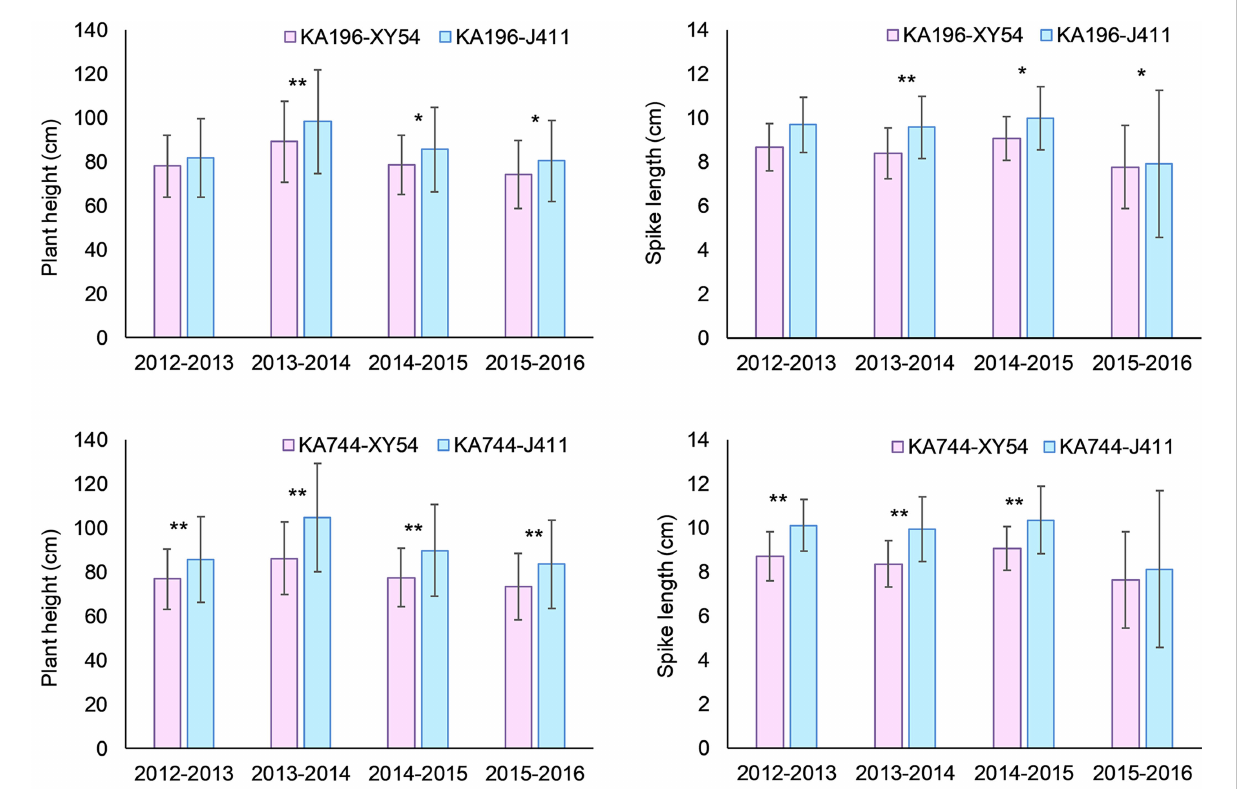
FIGURE 6 Mean difference in plant height (PH) and spike length (SL) between Xiaoyan 54 and Jing 411-derived alleles of KA196 and KA744 in the diversity panel. XY54 indicates the “ Xiaoyan 54 ” allele; J411 indicates the “ Jing 411 ” allele; * and ** indicate signi fi cant at 0.05 and 0.01 levels,